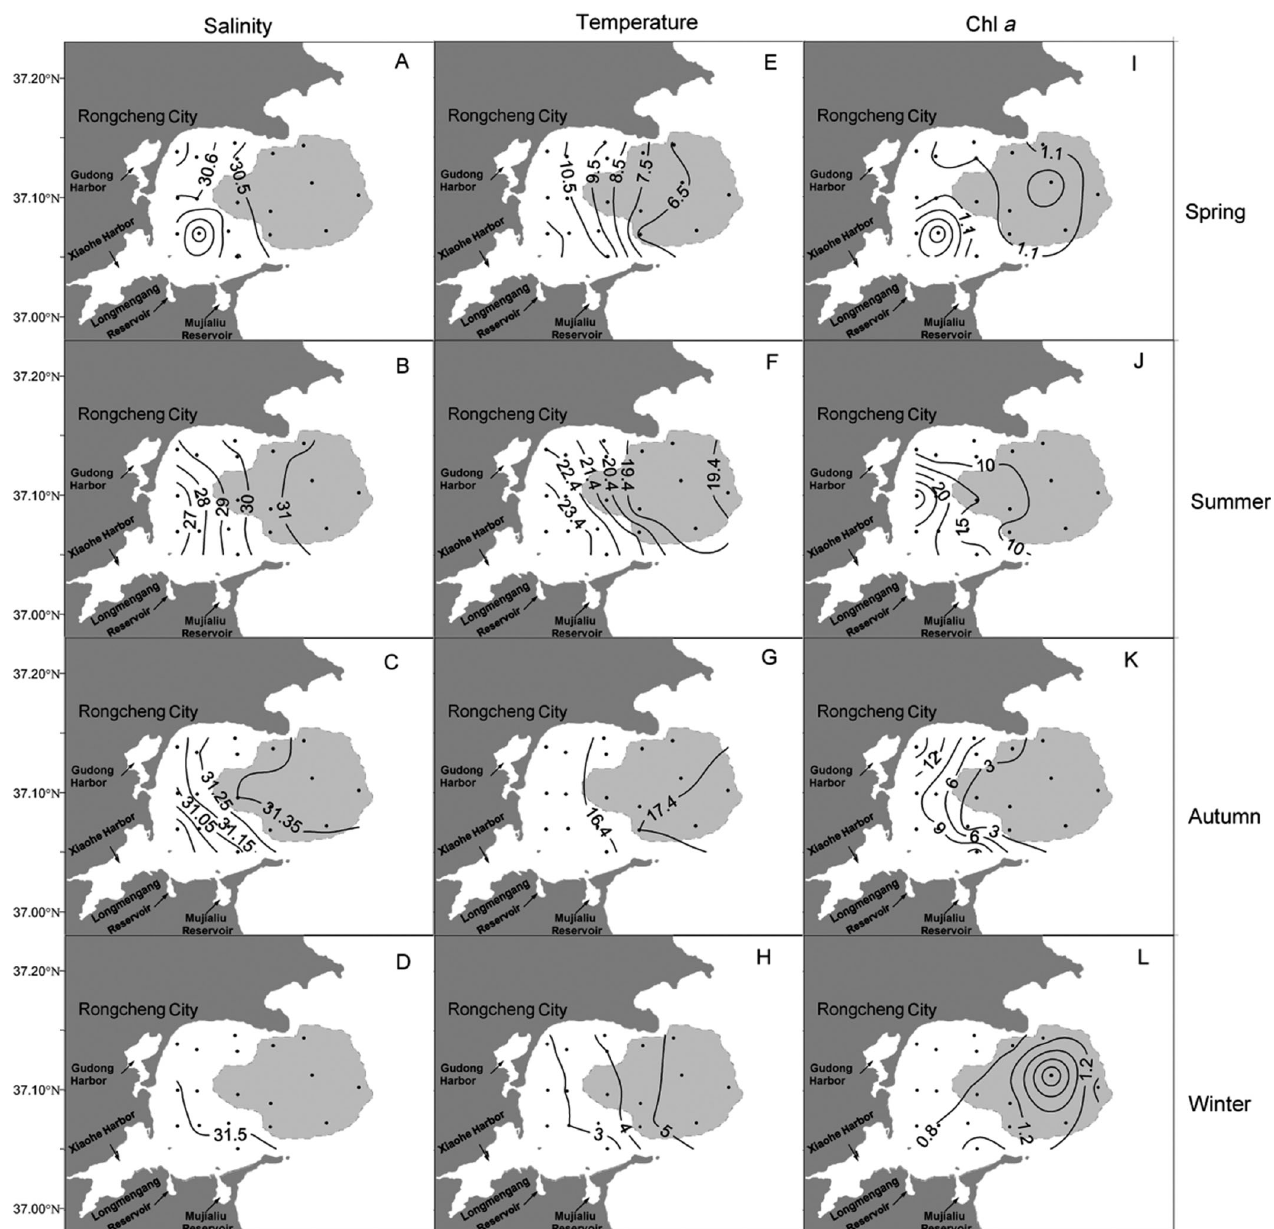
Fig. 2. Spatial variations in (A−D) salinity (psu), (E−H) temperature (°C) and (I−L) chl a biomass (µg l −1 ) over 4 seasons. Sampling stations, M-area and B-area are marked as in Fig.